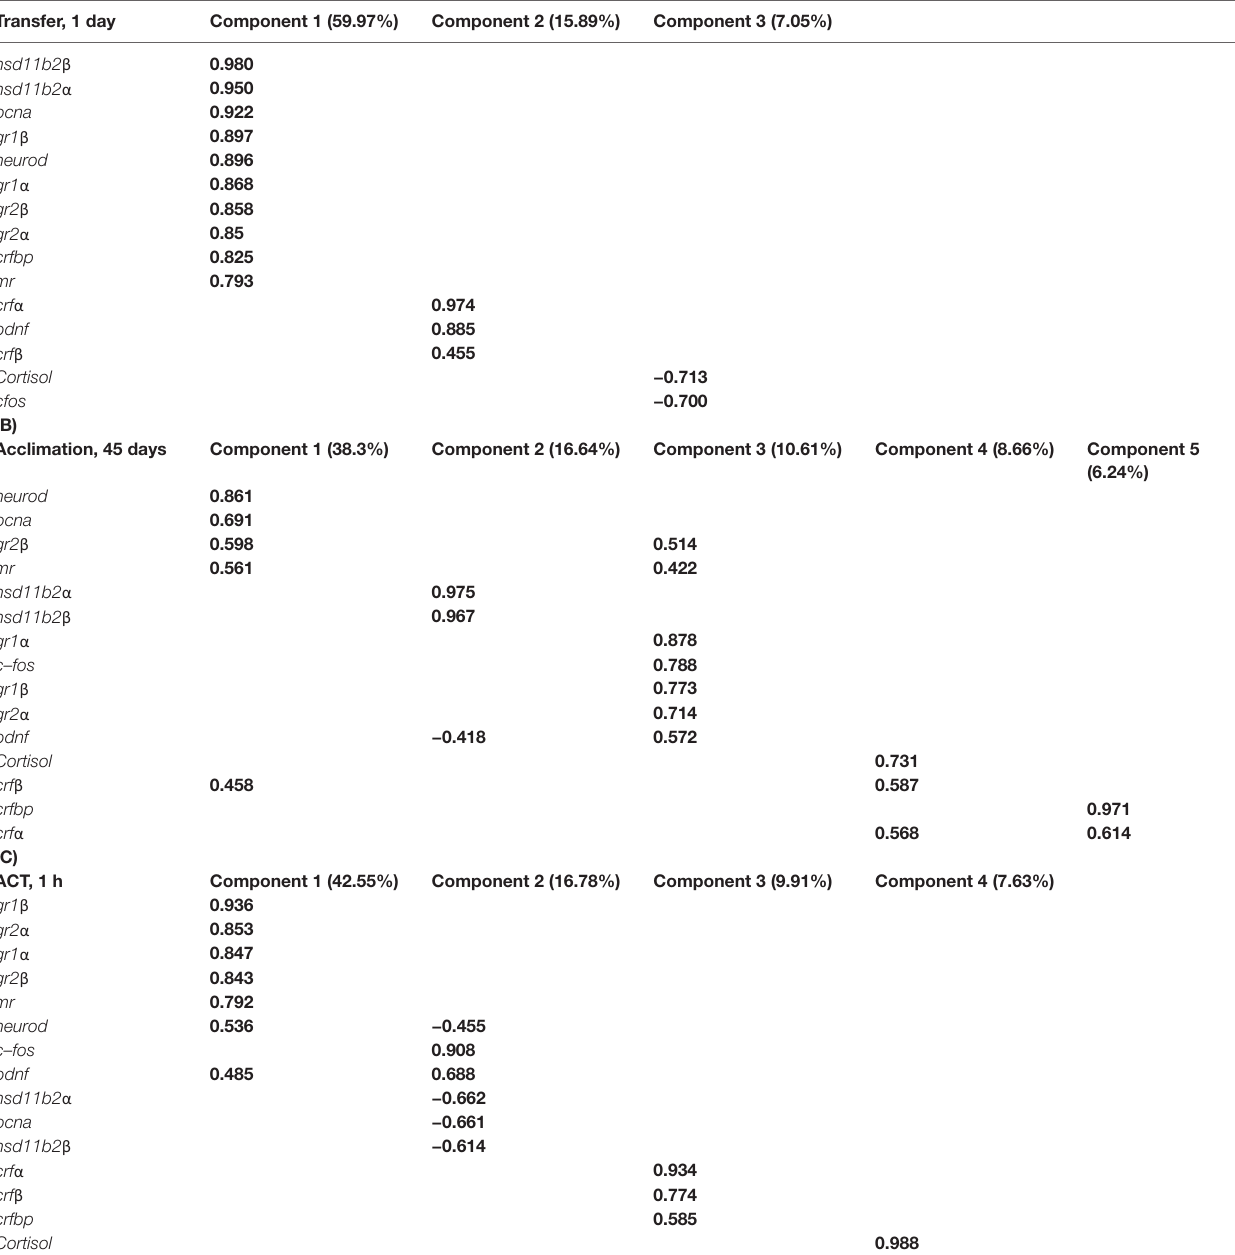
TABLE 2 | Variables loaded onto components in principal component analysis (PCA) within samplings: (A) Transfer (1d), (B) Acclimation (45d), and (C) ACT